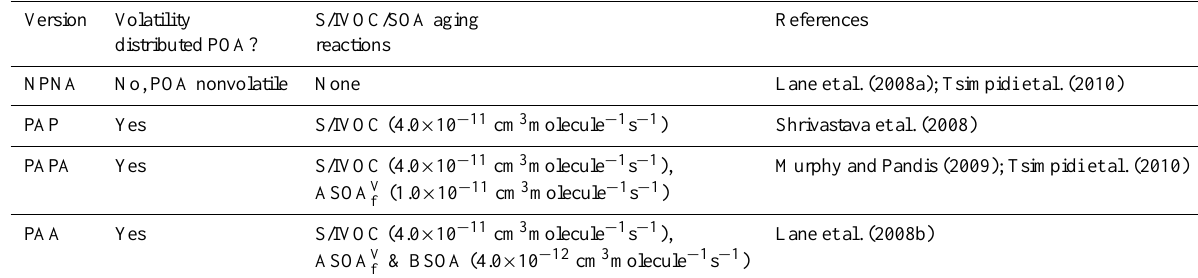
Table 3. Summary of the four EMEP model versions used in this